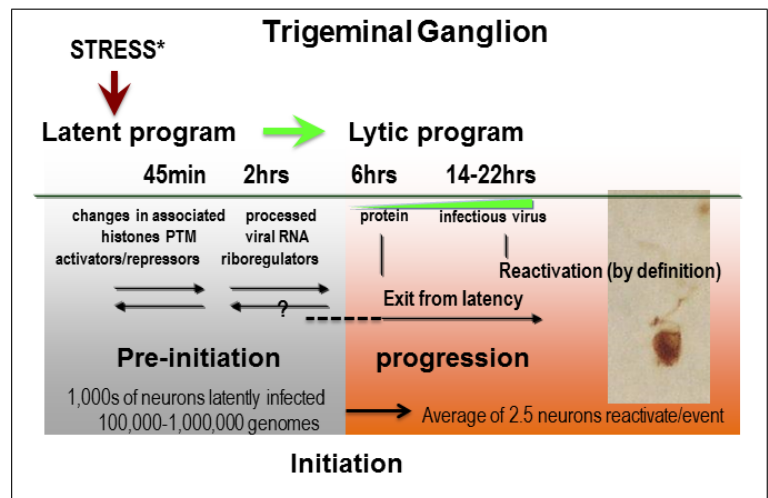
Figure 1. The process of herpes simplex virus (HSV) reactivation from latency. Some sensory neurons in the trigeminal ganglion (TG) of latently infected mice contain the viral genome, and the number of copies per neuron varies from 1 to more than 1000 57,58 . A subset of these neurons express the latency-associated transcript locus that expresses a primary transcript processed into small and long non-coding RNAs as well as very low-level transcription from most or all of the viral genome 52,54,59–61 . Following stresses that can induce viral reactivation from latency, changes in the post-translational modification (PTM) of histone tails on the viral genome can be rapidly detected and processed viral RNAs (e.g. spliced) become more abundant within the first few hours, but viral proteins are not detectable (reviewed in 2–5). Viral protein becomes detectable about six hours post-stress in very rare neurons, and we employ the term “initiation” to describe this event 57 . By twenty-two hours post-stress, infectious virus can be detected in 50–70% of the TG. Photomicrograph shows rare neuron in the process of